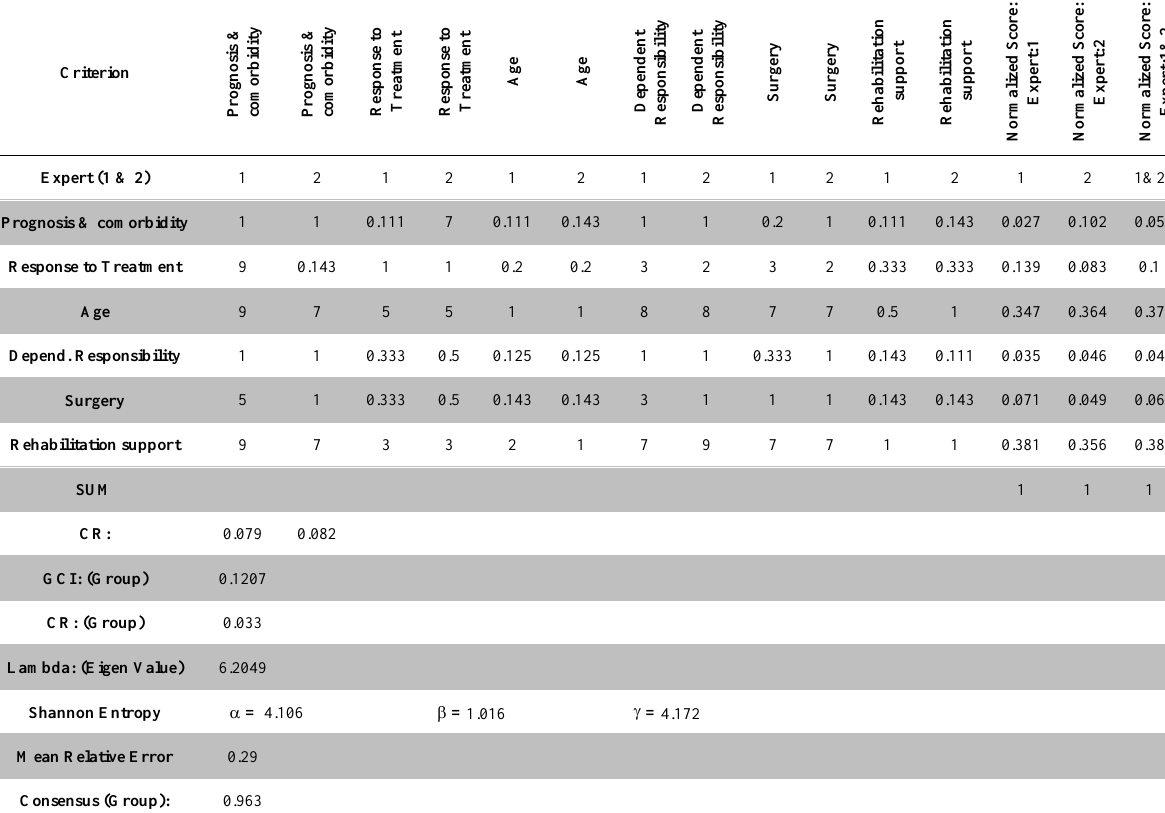
Table 13. Decision Matrix A: About Patient Case 4 (Expert 1 and